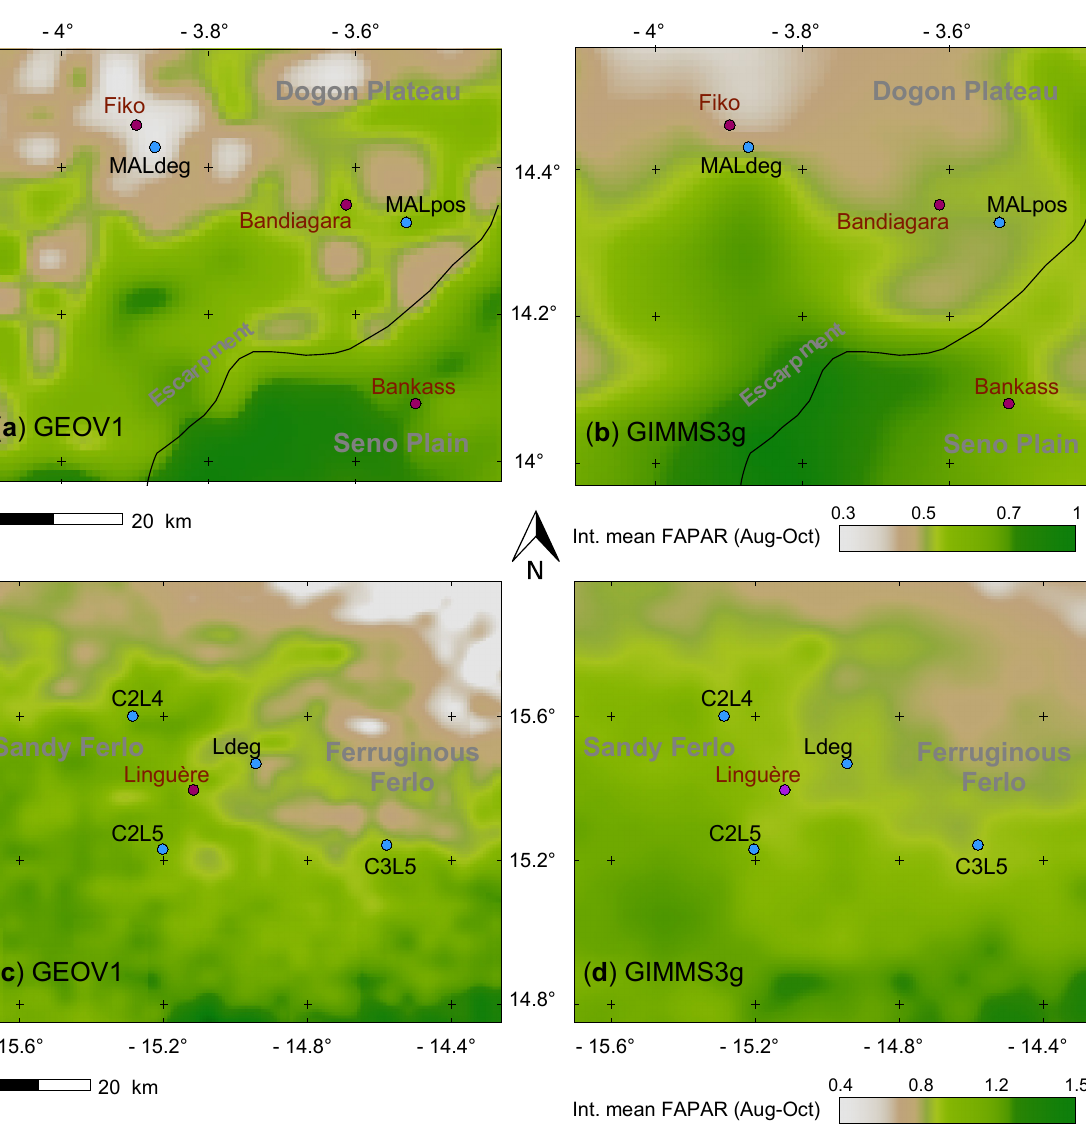
South-east of the Bandiagara escarpment, the Seno Plain represents a different morphological zone (Figure 2). In the absence of rocks and laterite, Dogon and Fulani farmers cultivate almost 90% of its deep sandy soils. In 1967, about 40% were still covered by dense bushland, which was cleared due to human expansion and the need for cropping land